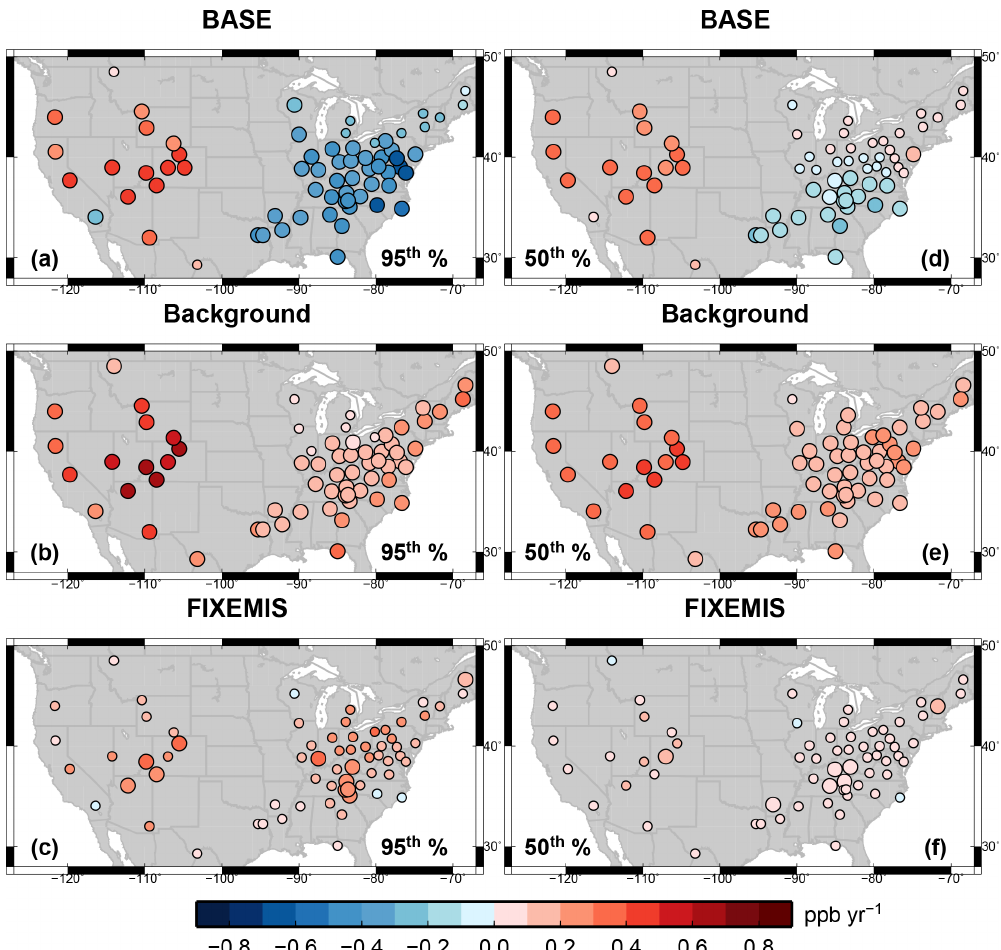
Figure 10. Linear trends in the 95th (left) and 50th (right) percentile springtime MDA8 O 3 over 1988–2014 at US rural sites from BASE (top), Background (middle) and FIXEMIS simulations (bottom). Larger circles indicate sites with statistically significant trends ( p <0.05). Top panels are repeated from Fig. 7d, e. Note that the 95th (50th) percentile is sampled separately from the Background and FIXEMIS simulations without depending on the times when the BASE simulation is experiencing the 95th (50th) percentile